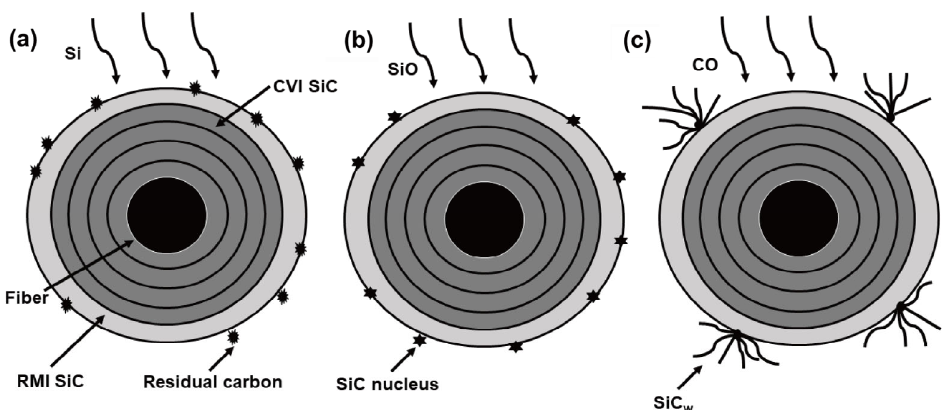
Fig. 6 Schematic diagram showing the formation of SiC w .